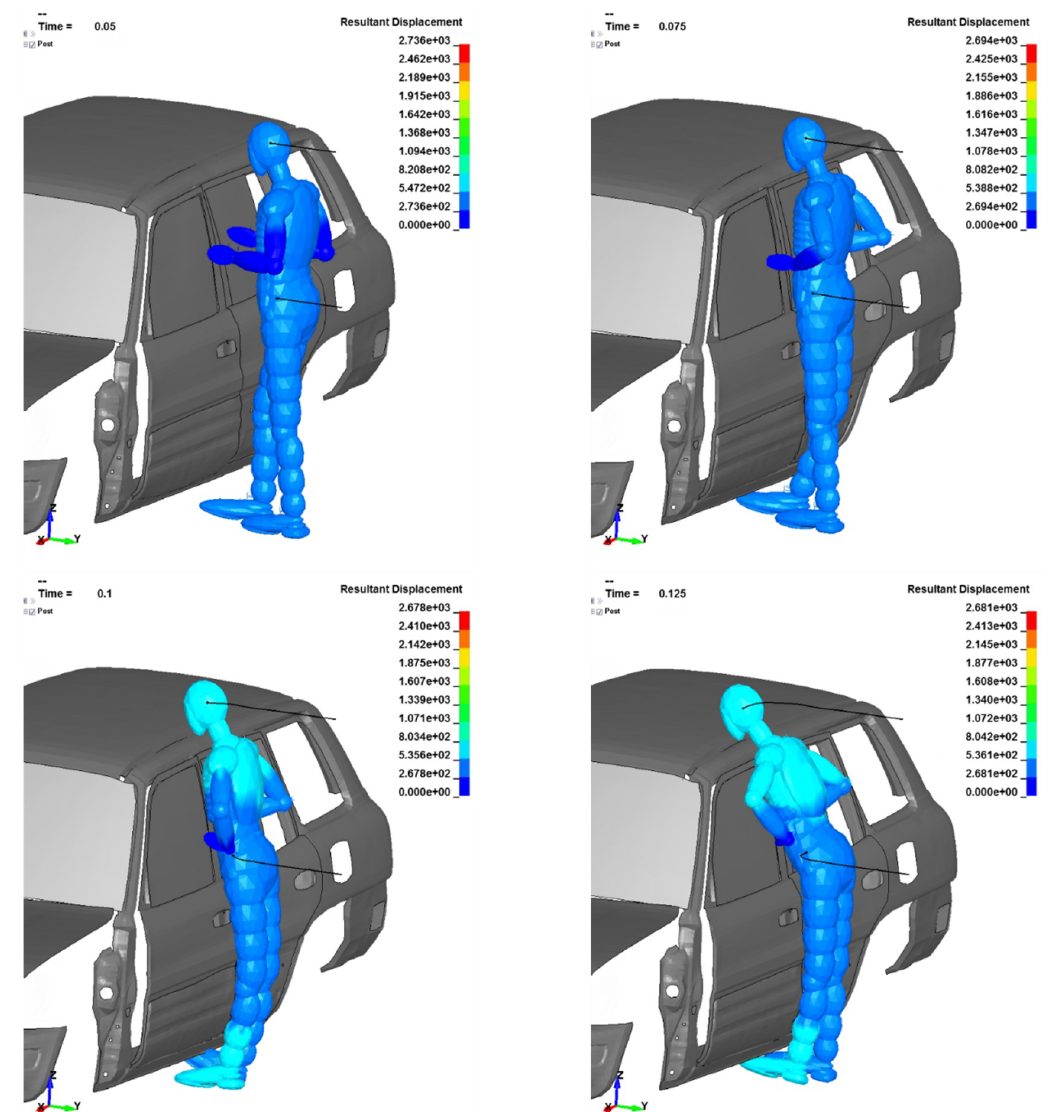
Fig 6. Dummy kinematics in the B-pillar, up-right scenario—The dummy’s resultant displacement in [mm], time in [s].